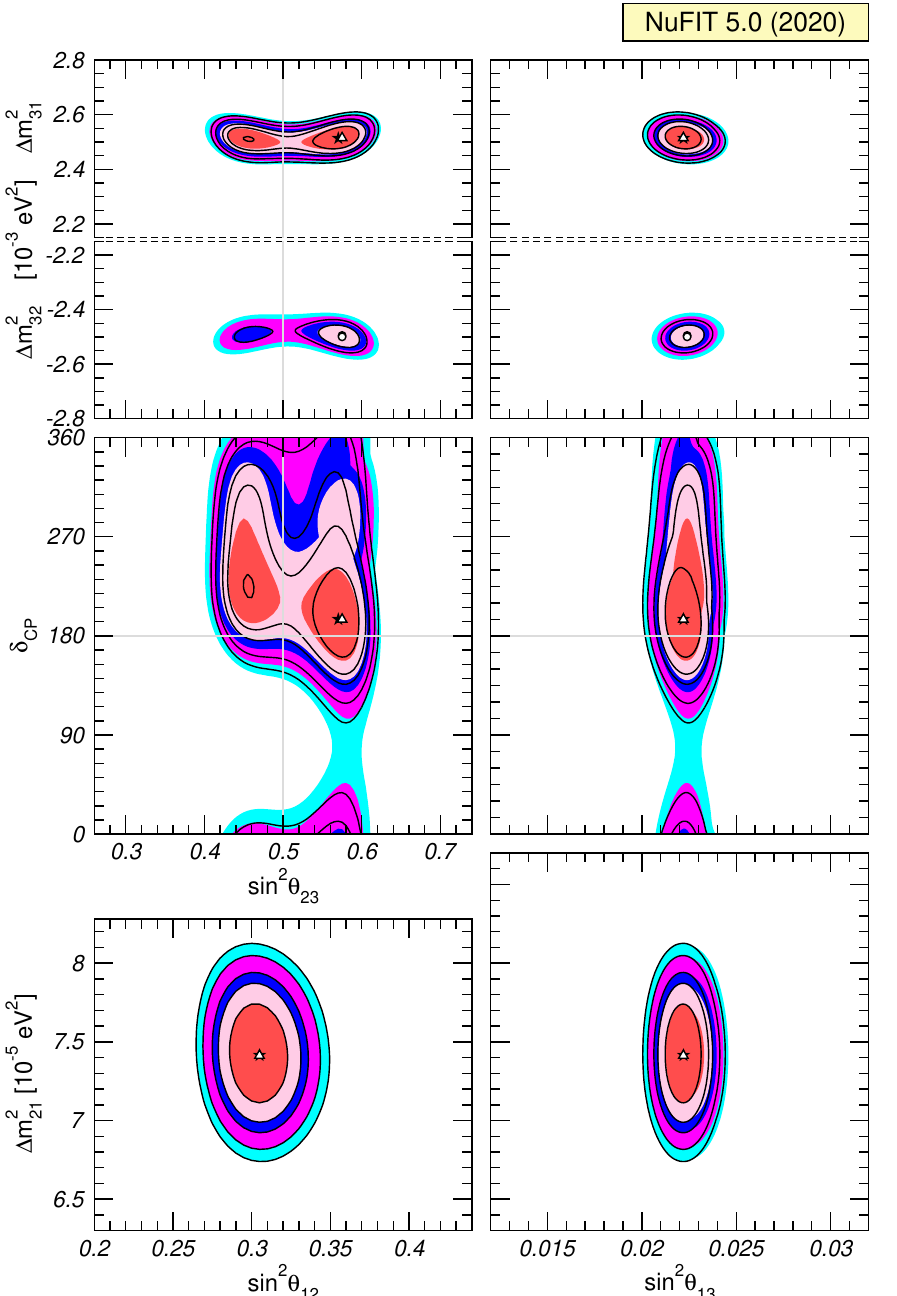
Figure 7 . Global 3 (cid:23) oscillation analysis. Each panel shows the two-dimensional projection of the allowed six-dimensional region after minimization with respect to the undisplayed parameters. The regions in the four lower panels are obtained from (cid:1) (cid:31) 2 minimized with respect to the mass ordering. The di(cid:11)erent contours correspond to 1 (cid:27) , 90%, 2 (cid:27) , 99%, 3 (cid:27) CL (2 dof). Colored regions (black contour curves) are without (with) adding the tabulated SK-atm (cid:1) (cid:31) 2 . Note that as atmospheric mass-squared splitting we use (cid:1) m 2 for NO and (cid:1) m 2 for IO. 31 32